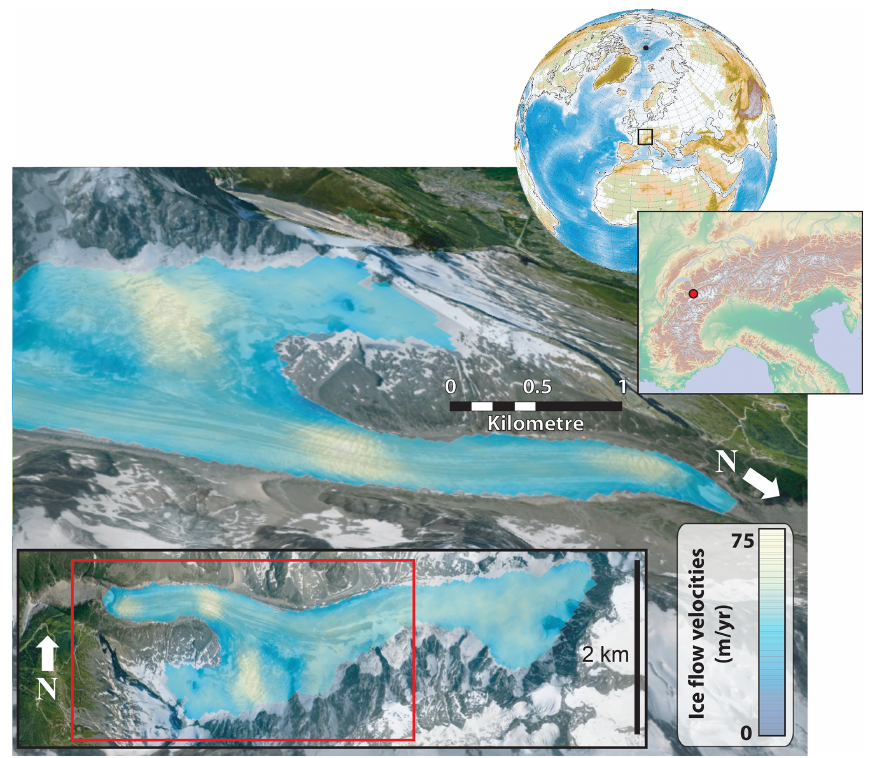
Figure 7. Perspective view of mean flow velocities of Glacier d’Argentière, France, over the period March 2019–March 2020. Imagery is from © Google Earth, and scale is for near margin of